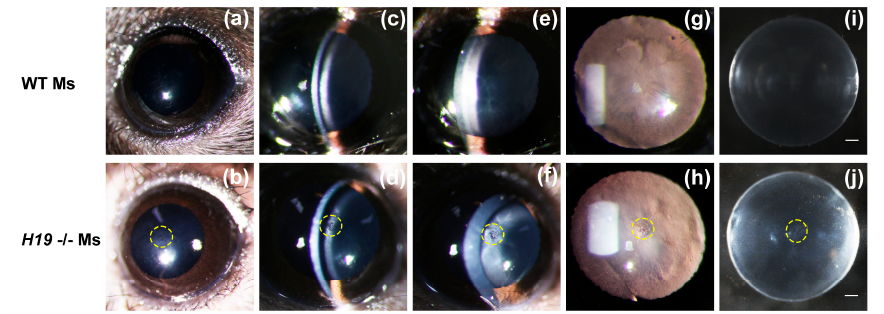
Figure 8. H19 knockout mice displayed anterior polar cataracts and delayed anterior suture fusion. ( a – h ) Photos were taken under slit lamps after the mice were anesthetized and their pupils were dilated. The ocular lenses of 8-week H19 (-/-) mice and the wild-type littermates were examined in-vivo by Haag-Streit BX 900 slit lamp with a diffuse illumination mode ( a , b ), a narrow slit mode ( c , d ), a moderate slit mode ( e , f ), and a retro-illumination mode ( g , h ). ( i , j ) Photos of freshly enucleated lenses from 8-week H19 (-/-) mice and the wild-type littermates. Observations in both eyes were similar, and representative pictures of one eye were shown here. Scale bars, 0.5 mm.